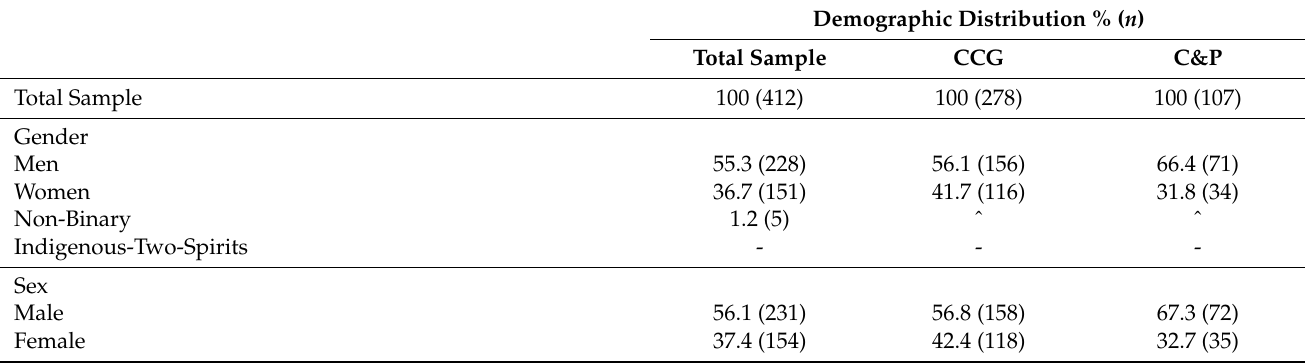
Table 1. Sociodemographic